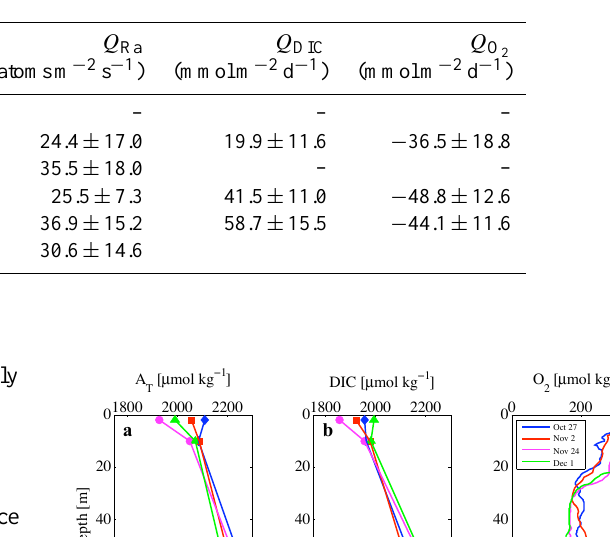
Table 1. Results from 224 Ra, carbon and oxygen analyses. Daily results of eddy diffusion coefficients ( K Z ), 224 Ra activities at the sediment- water column interface ( A 0 ), as well as benthic fluxes of 224 Ra ( Q Ra ) and DIC ( Q DIC ) out of the sediments (indicated by positive values) and fluxes of oxygen ( Q O ) into the sediments (indicated by negative values), are shown. 2